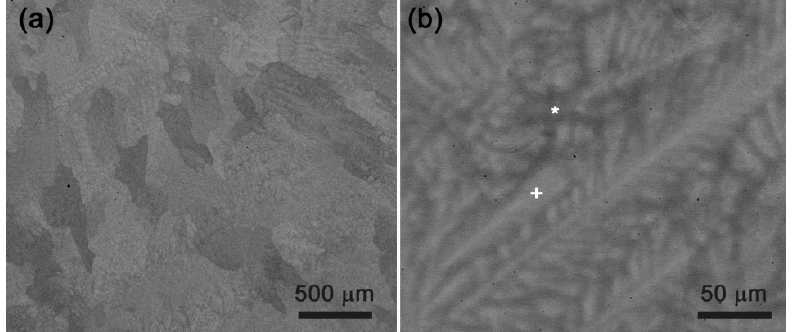
Figure 6. SEM micrographs (back-scattered electrons) of HfNbTaTiZr alloy in the as-cast state: ( a ) an overview of the microstructure, ( b ) detail of the microstructure taken in higher magnification. Region used for EDS point scans to determine the composition of the Ti, Zr and Nb, Ta-rich phases are denoted by the star and cross symbols, respectively.